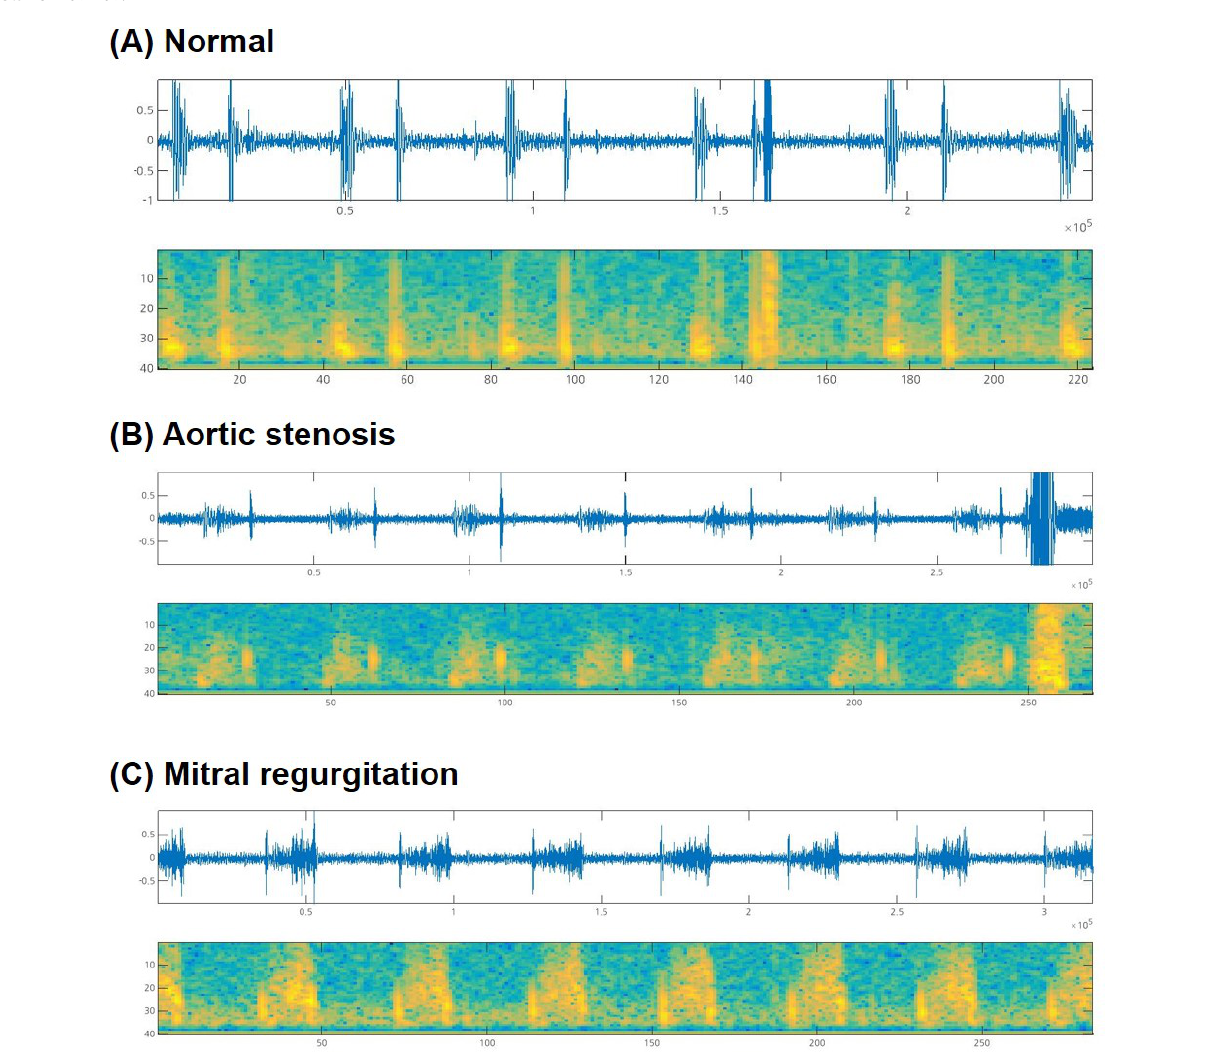
Figure 3. Representative phonocardiograms and spectrograms. (A) Normal heart sounds from the aortic area of a 22-year-old man with a history of vasovagal syncope. (B) Midsystolic ejection murmur from the aortic area of an 83-year-old woman with aortic stenosis, which was classified as a systolic murmur. (C) Systolic murmur from the mitral area of a 63-year-old woman with mitral valve prolapse and mitral regurgitation, which was classified as a systolic